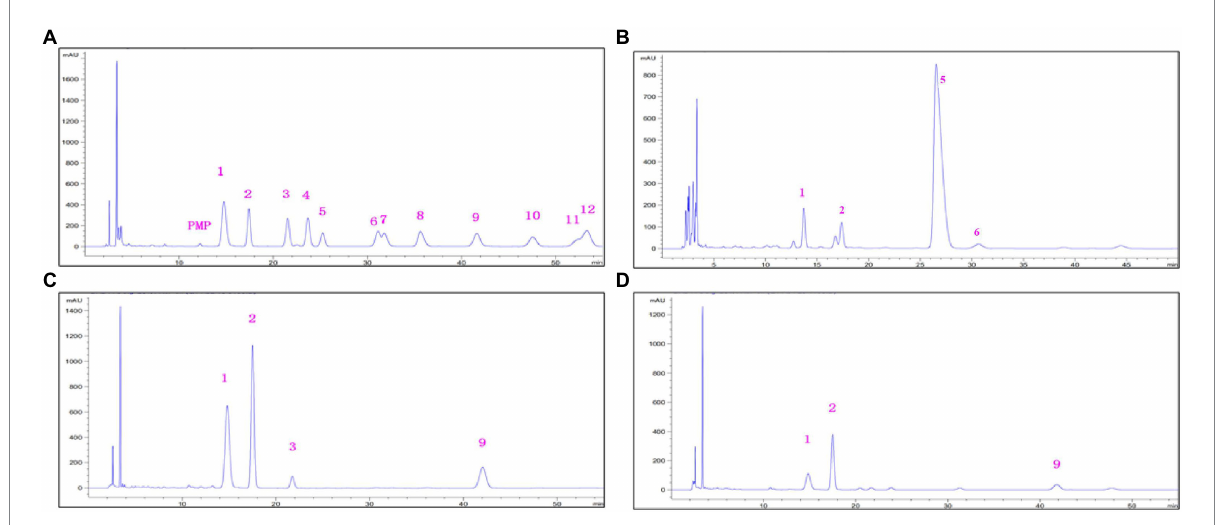
FIGURE 4 HPLC chromatograms o of standard monosaccharides (A) , monosaccharides derivatives from EPS-F10 (B) , EPS-S5 (C), and EPS-S8 (D) (1, Man; 2, GlcN; 3, Rib; 4, Rha; 5, GlcUA; 6, GalUA; 7, GalN; 8, Glc; 9, Gal; 10, Xyl; 11, Ara; 12,